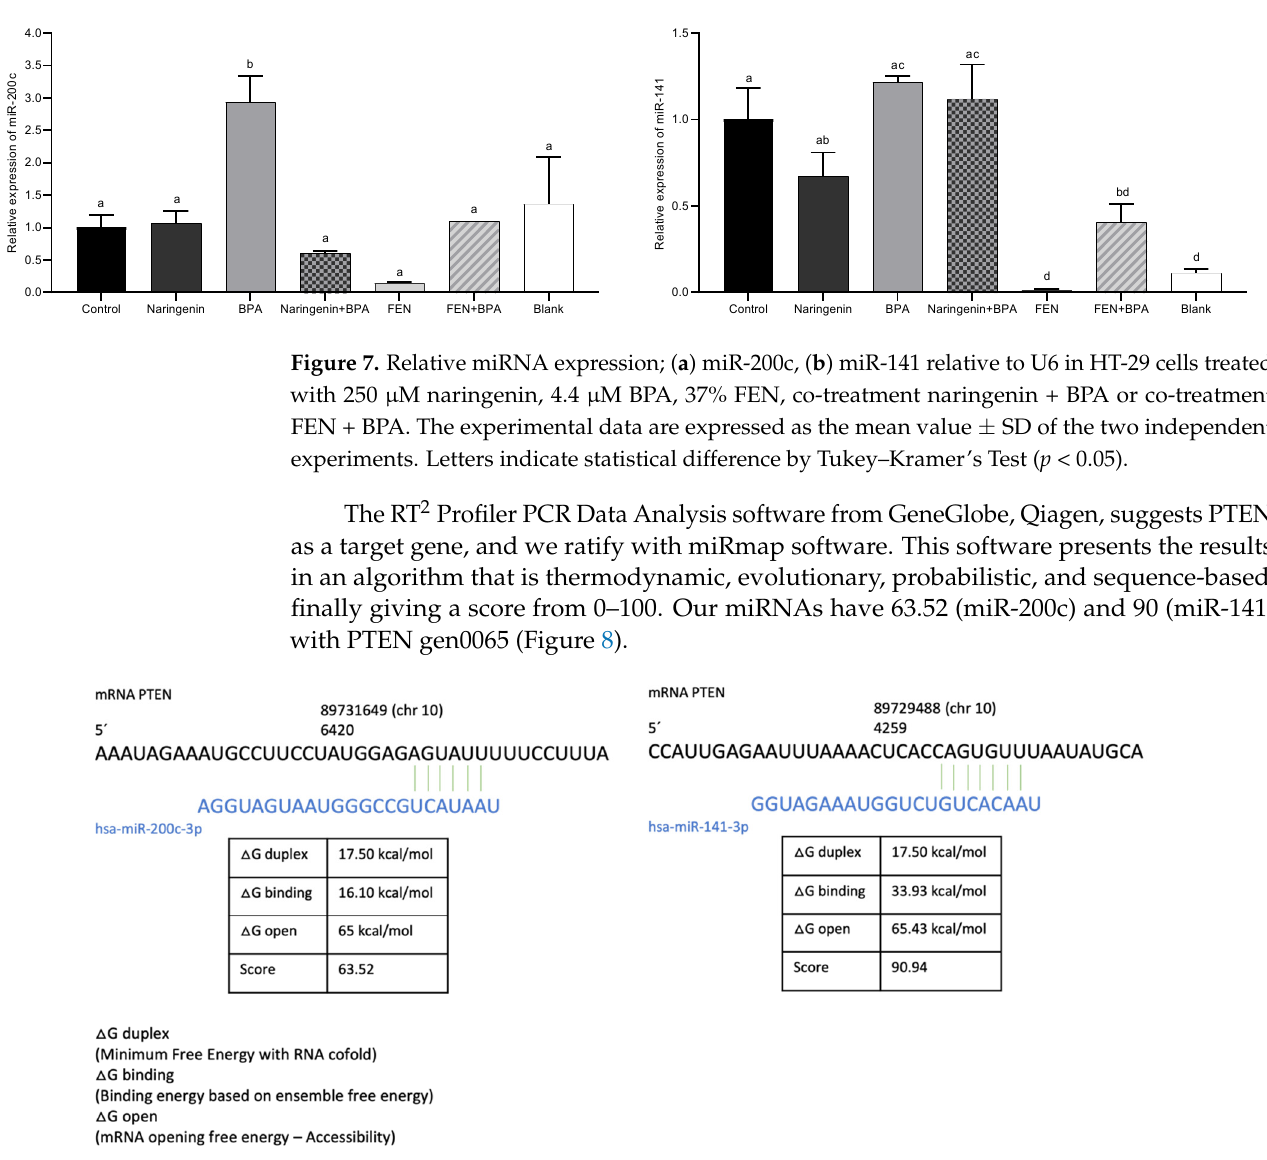
Figure 8. Comprehensive prediction of PETEN repression by miR-200c and miR-141 simulated in miRmap.